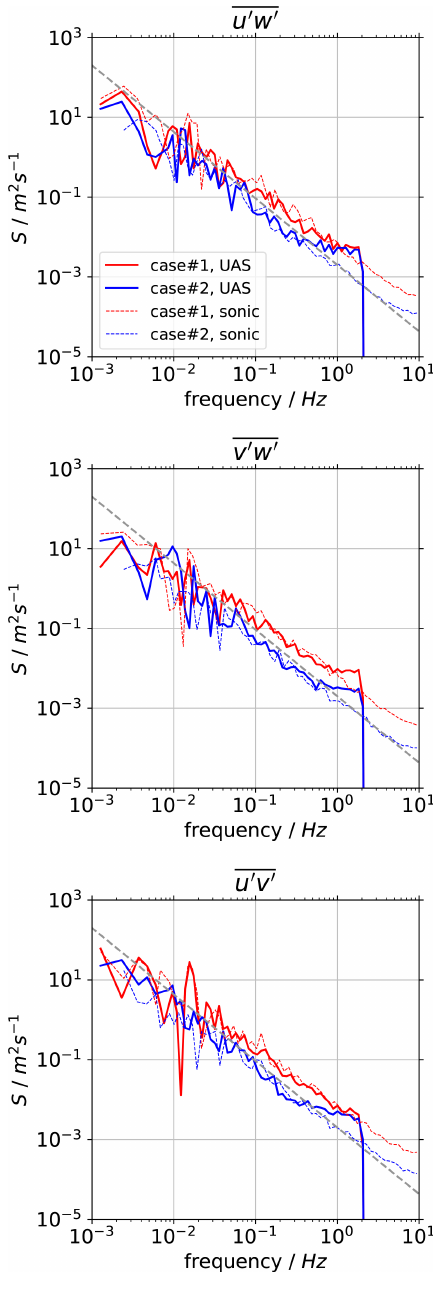
Figure 10. Comparison of power cospectra between sonic anemometers and